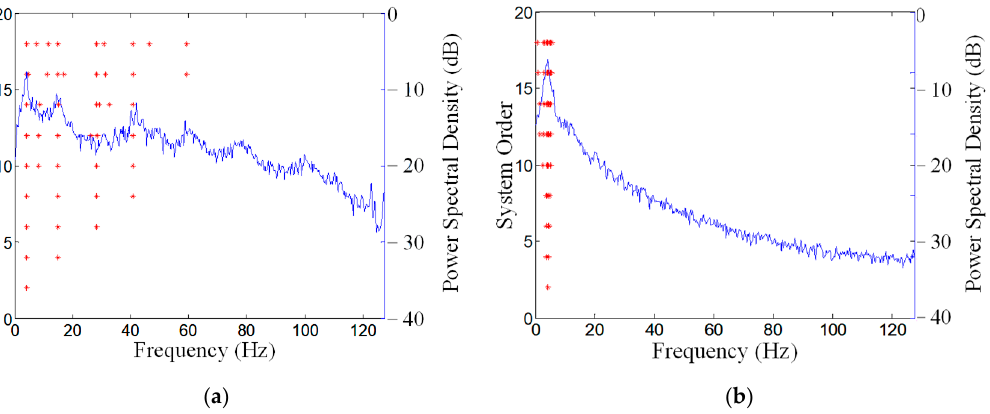
Figure 9. Stabilization diagram of original and decomposed acceleration response for the shaking table test. ( a ) Original data; ( b ) IMF10.